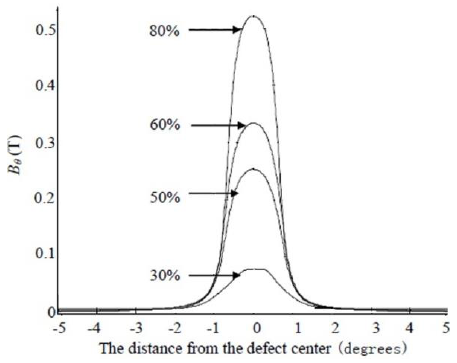
Figure 7. Circumferential MFL signals with different depth.